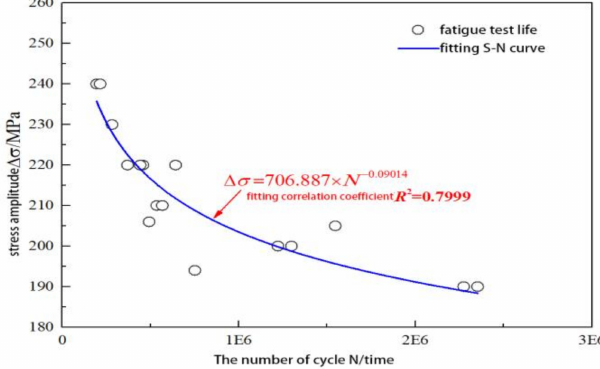
Figure 8. The power regression S-N curve with the stress range as parameter.